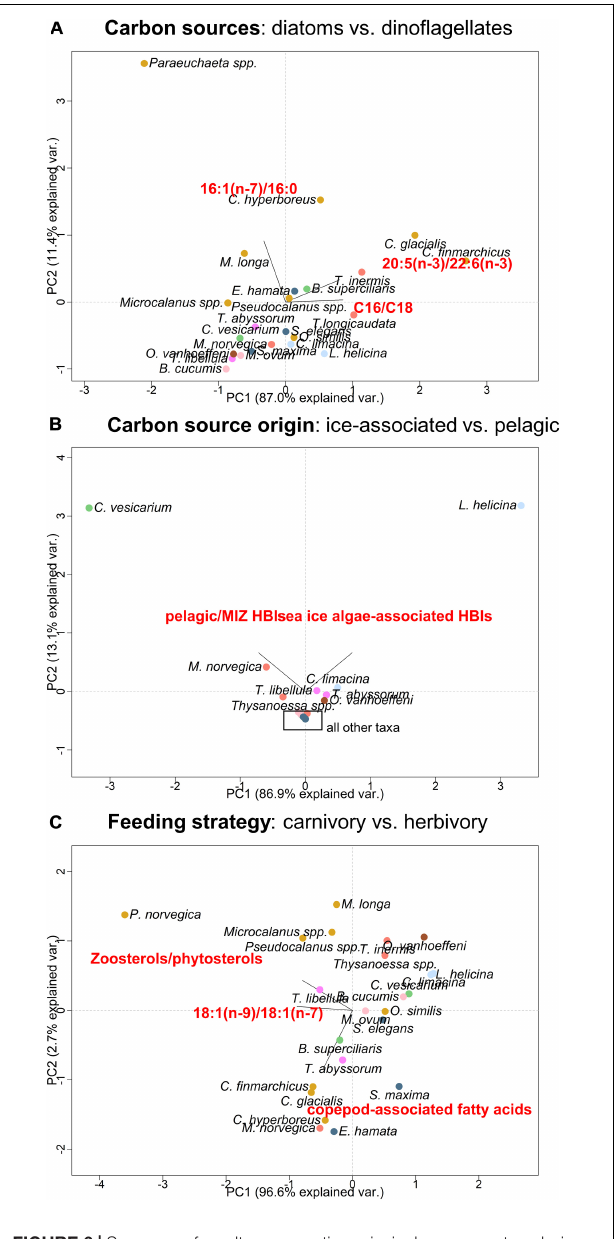
FIGURE 6 | Summary of results representing principal component analysis (PCA) of (A) the carbon source composition based on diatom- versus dinoflagellate-associated fatty acids (FAs; trophic marker FA ratios are shown in Table 3 ), (B) the origin of these carbon sources based on concentrations of pelagic/MIZ highly branched isoprenoids (HBIs III and IV) and sea ice algae-associated HBIs (IP 25 , IPSO 25 ; HBI concentrations are shown in Figure 5A and Supplementary Table 5 ) and (C) the degree of carnivory versus herbivory in the zooplankton taxa based on concentrations of zoosterols/phytosterols, and relative proportions of the carnivory FA 18:1( n –9) versus the algal-produced FA 18:1( n –7), and calanoid copepod-associated FAs 20:1 and 22:1 (FA proportions are shown in Supplementary Table 3